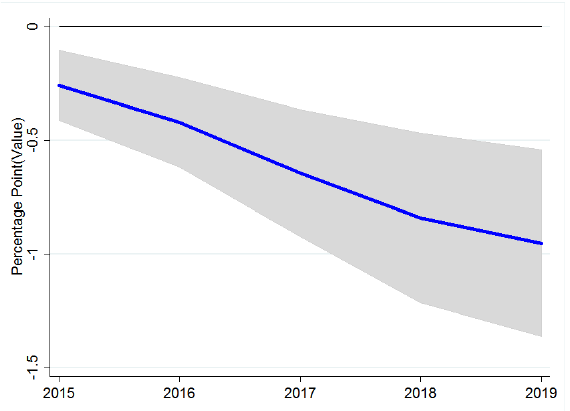
Figure 1. Cumulative Response of MarketShare to NGER.